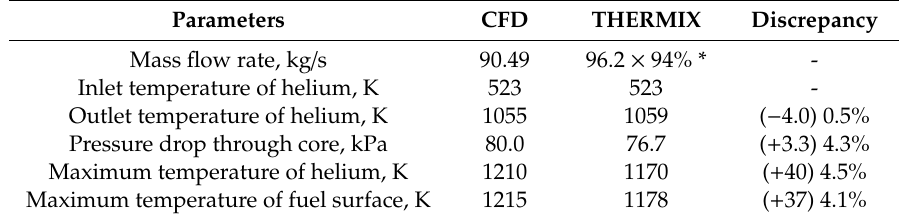
Table 1. Comparisons of the results from CFD and THERMIX.